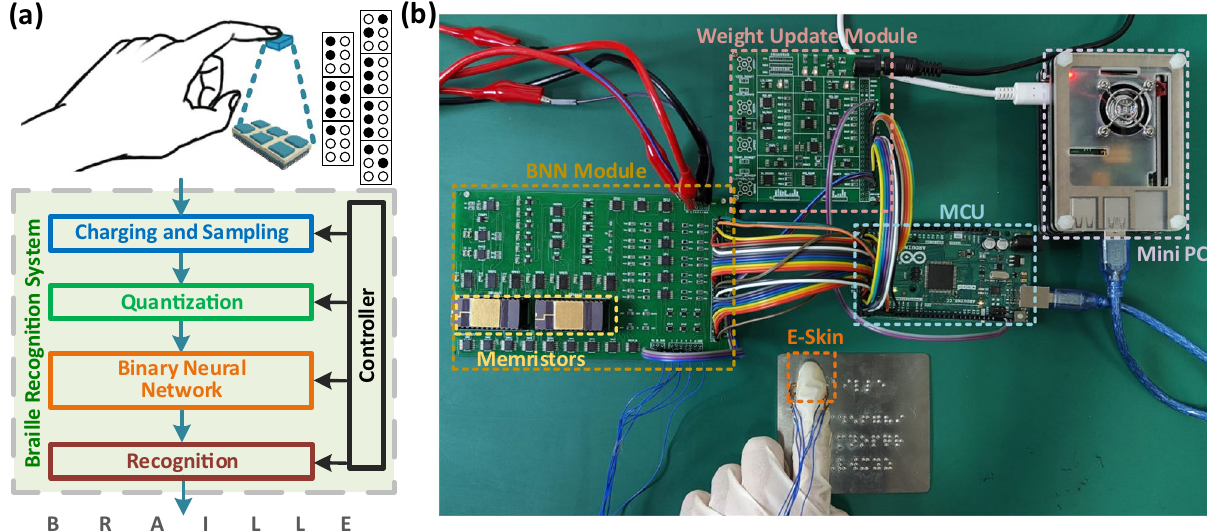
Figure 1. ( a ) Illustration of operation of the intelligent Braille recognition system consisting of the E-skin and memristor-based BANN; and ( b ) photograph of the hardware of the